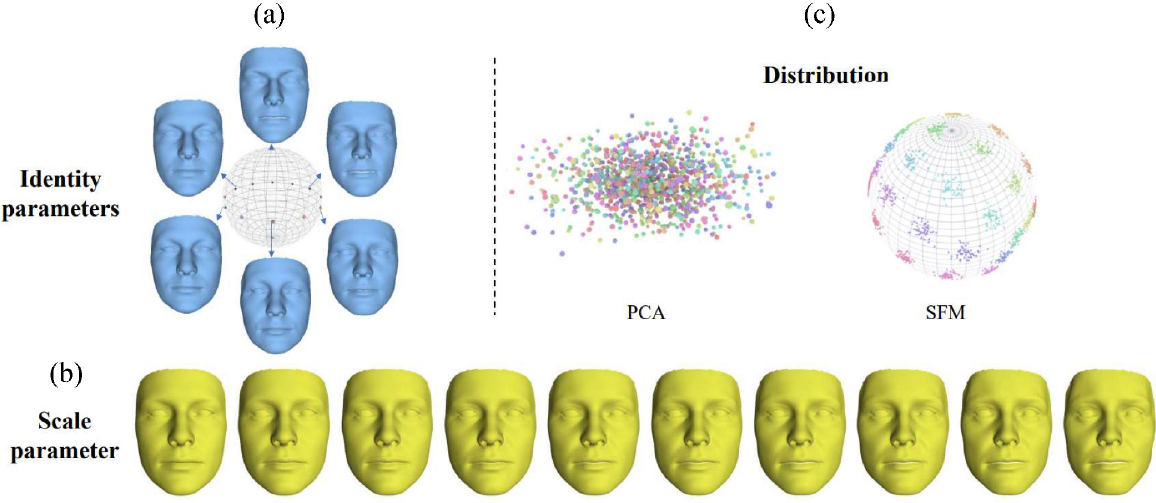
Fig. 1 Overview of the Sphere Face Model. (a) Identity parameters of the sphere face model distributed on the hypersphere represents the identity information. The meshes are uniformly sampled from on the hypersphere using the first two dimensions of identity parameters. (b) Scale parameter of the sphere face model is scalar, which controls the distinctiveness to the mean face. (c) Distribution of the parameter. The shape parameter of the PCA-based model has an anisotropic multivariate Gaussian distribution. Our identity parameters are distributed isotropically on the hypersphere and separated between different